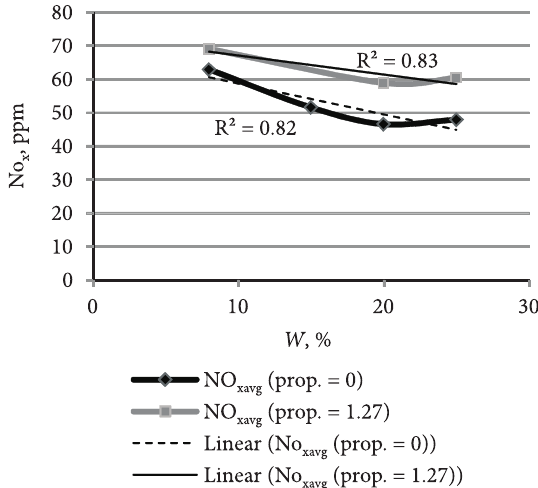
Fig. 5. The O /O changes in products depending on 2avg. 2max moisture content in wood pellets and supply of propane-butane in combustion zone